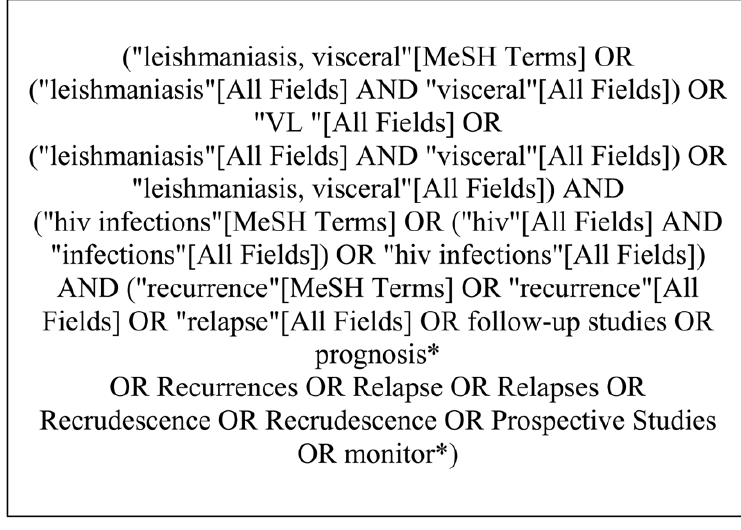
Figure 1. Terms used in Medline/PubMed search.